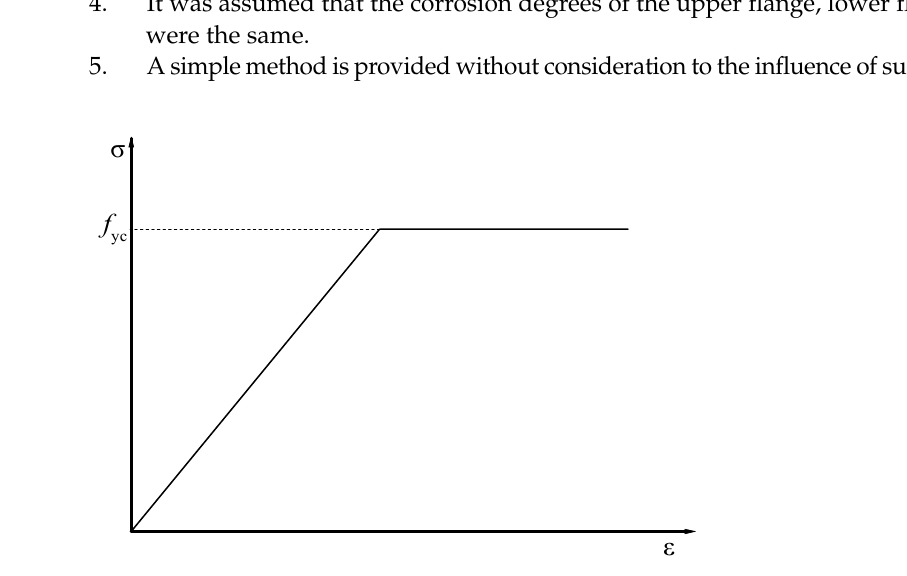
Figure 14. Stress ‐ strain relationship of corroded steel.